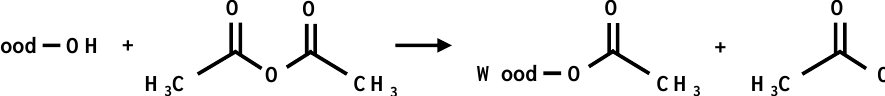
Figure 4. Reaction of wood with acetic anhydride [156]. Reprinted by permission from Springer Nature: Springer Nature, Journal of Journal of Coatings Technology and Re-search (Performance of finishes on wood that ischemically modified by acetylation, Beckers, E.P.J. et al.), 1998.